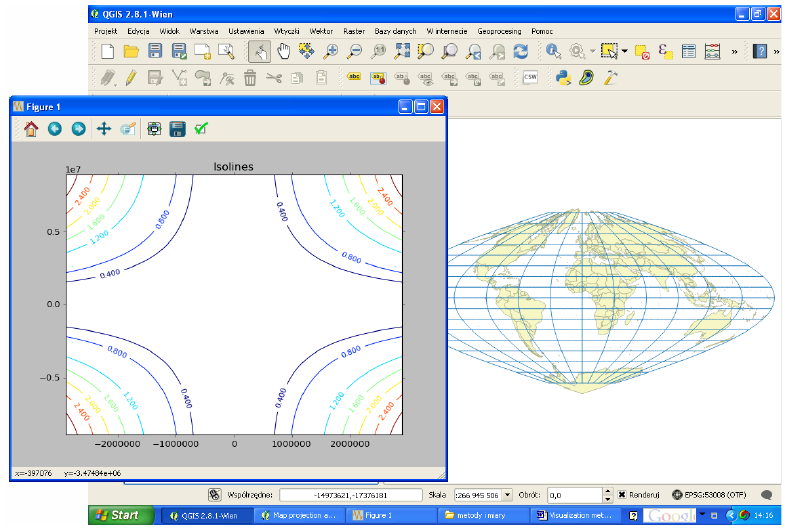
Fig. 16. The isolines generated by the developed plug-in